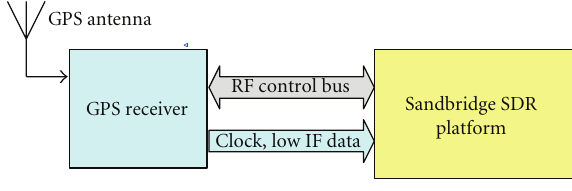
Figure 7: GPS test